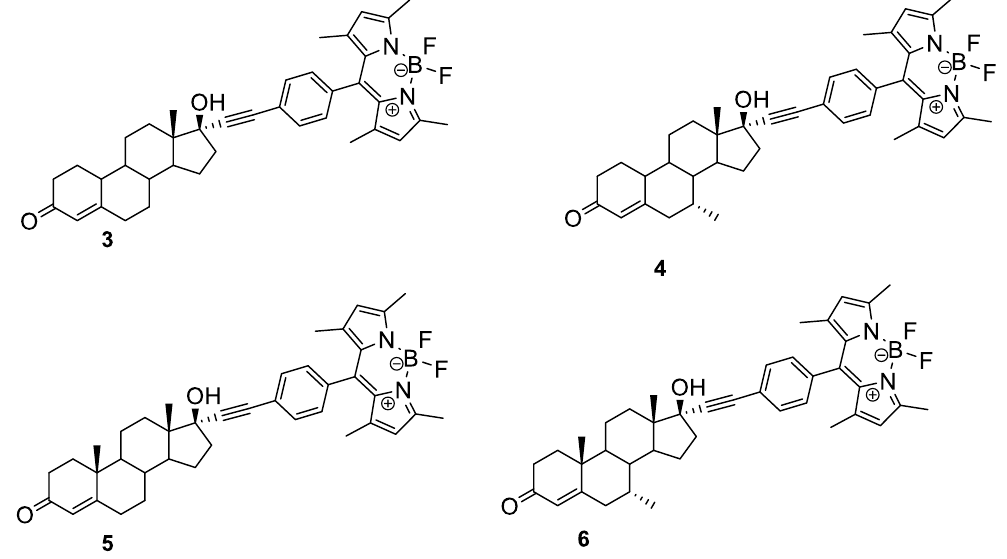
Scheme 2. Structures of 19-nortestosterone- and testosterone-BODIPY conjugates.